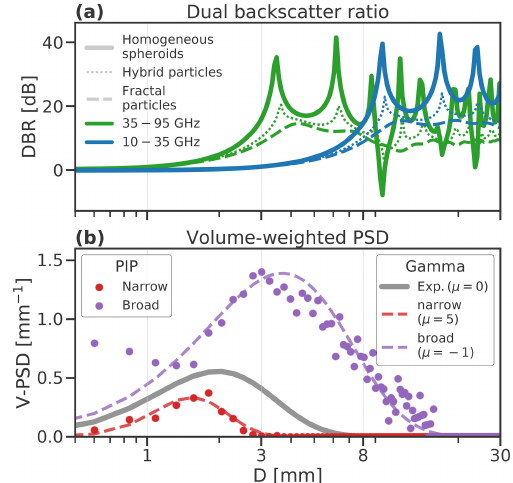
Figure 4. (a) Normalized dual-backscatter ratios (DBRs) at 10– 35 and 35–95GHz bands for fractal particles (aggregates of bullet rosettes) and homogeneous spheroids on the same size spectrum as (b) the volume-weighted PSD (V-PSD) measured in situ dur- ing the 21 February case study (Sect. 4) and gamma PSDs fit to the same regimes, and an exponential PSD ( µ = 0). The backscat- ter cross section ratios of the hybrid particles in (a) illustrate the transition between aggregates of bullet rosettes and homogeneous spheroid approximations for intermediate density factors between 0 . 2 < r < 0 . 5, as described in Mason et al.